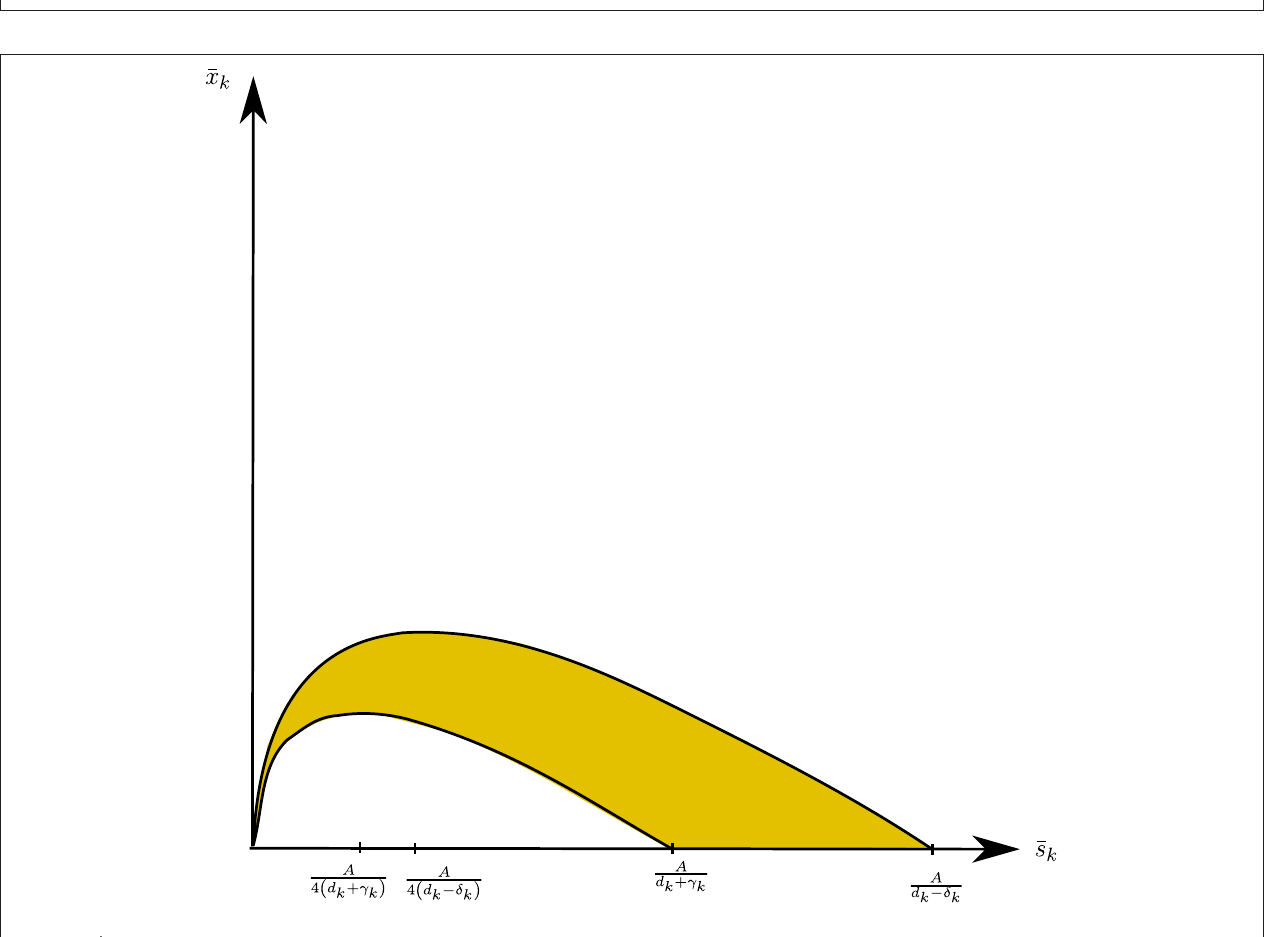
FIGURE 8 | Region of interior steady states